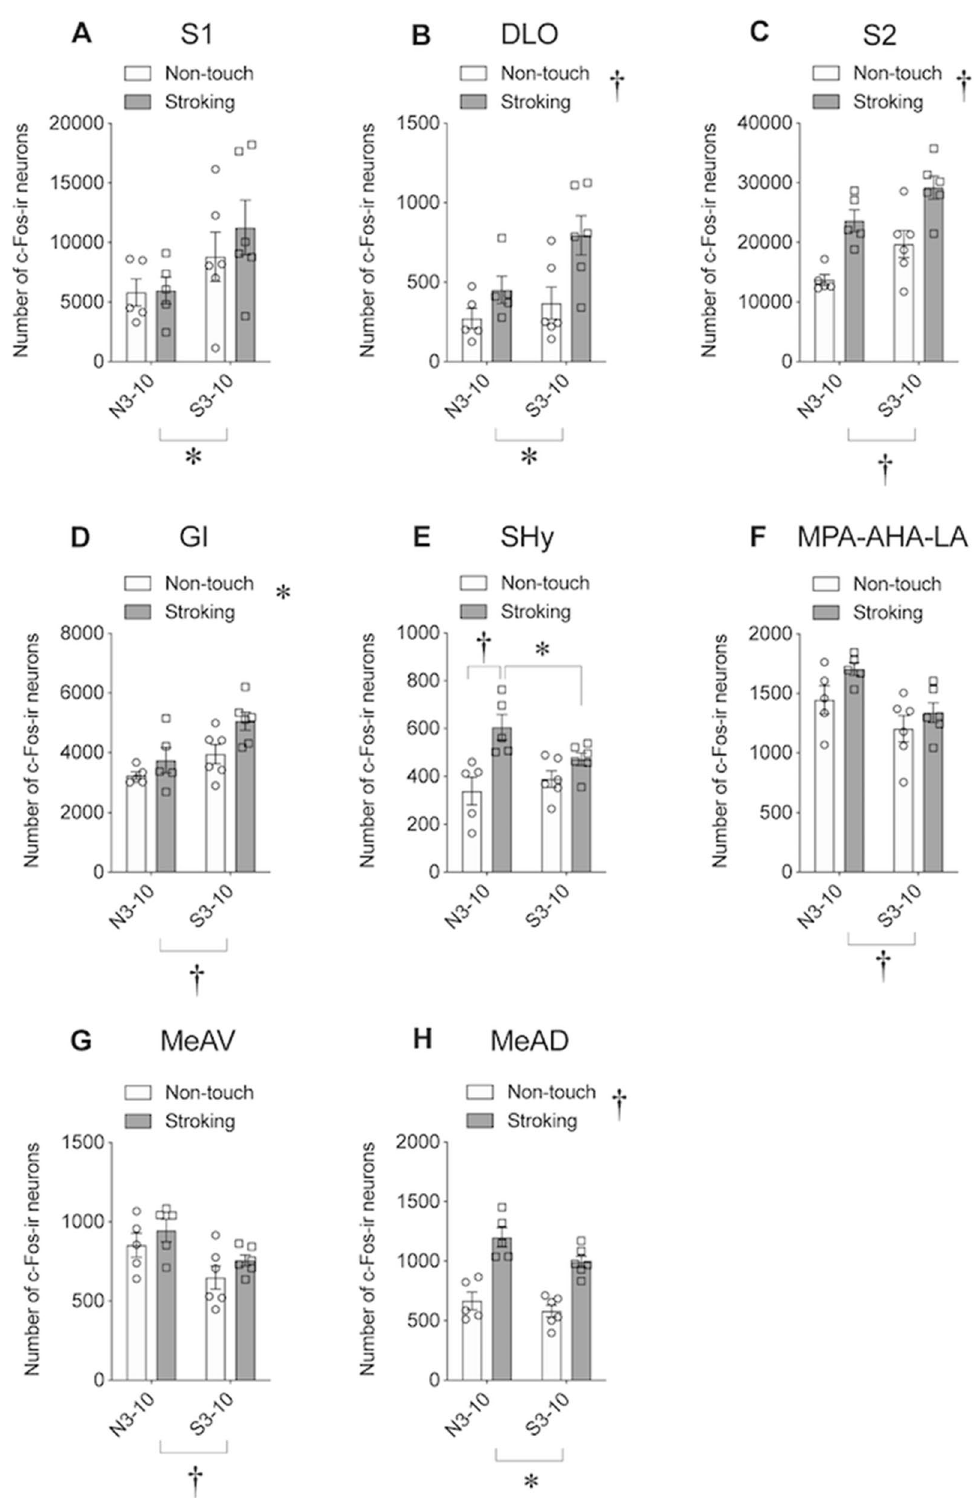
Figure 7. Number of c-Fos immunoreactive (-ir) cells after stroking stimuli. ( A – H ) Numbers of c-Fos-ir cells in the primary somatosensory cortex (S1) ( A ), dorsolateral orbital cortex (DLO) ( B ), secondary somatosensory cortex (S2) ( C ), granular insular cortex (GI) ( D ), septhohypothalamic nucleus (SHy) ( E ), medial preoptic area (MPA)-anterior hypothalamic area (AHA)-lateroanterior hypothalamic area (LA) ( F ), medial amygdaloid nucleus anteroventral part (MeAV) ( G ), and medial amygdaloid nucleus anterodorsal part (MeAD) ( H ). There was a significant effect of group (N3-10 vs. S3-10) in the S1, DLO, S2, GI, MPA-AHA-LA, MeAV, and MeAD. A significant effect of stimuli (non-touch vs. stroking) was also found in the DLO, S2, GI, and MeAD. There was significant interaction in the SHy. †, P < 0.01, *, P < 0.05. Two-way factorial ANOVA (group × stimuli) followed by post-hoc Holm’s test was used (see Supplementary Tables 1–3 for